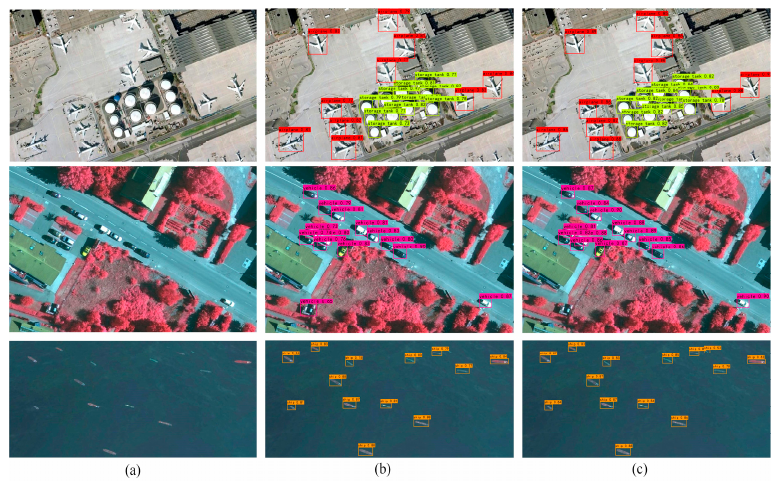
Figure 10. Detection results for the NWPU VHR-10 dataset: ( a ) input image; ( b ) for YOLOX-s; ( c ) for MFANet. Table 5. AP and mAP of the different algorithms acting on multiple object categroies from NWPU VHR-10 data. AP stands for average precision and mAP stands for mean average precision.